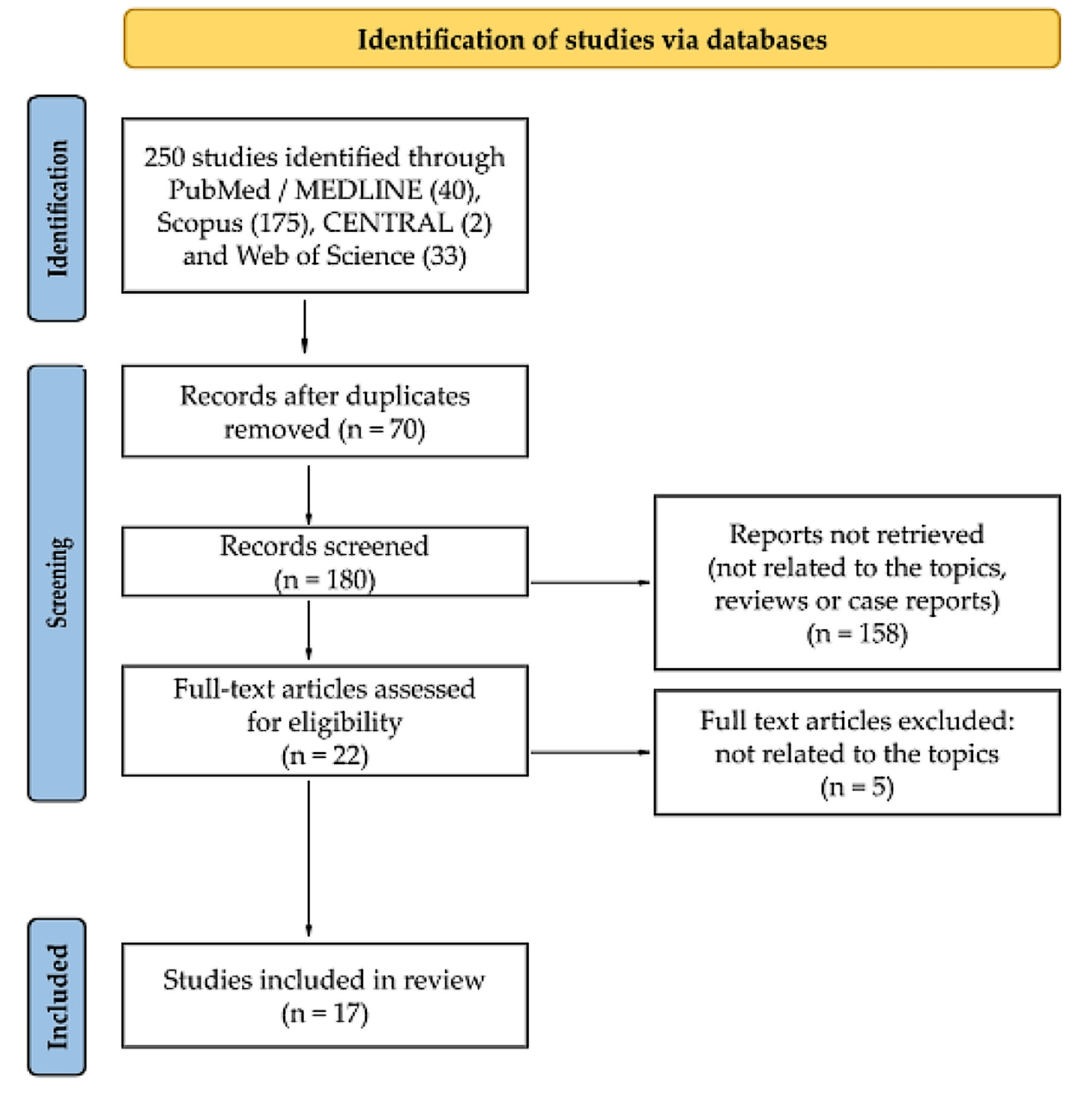
Figure 1. Flow diagram of the systematic literature search. The Preferred Reporting Items for Systematic Reviews and Meta-Analyses (PRISMA) flow diagram shows the study selection process. Table 1. The inclusion and exclusion criteria.